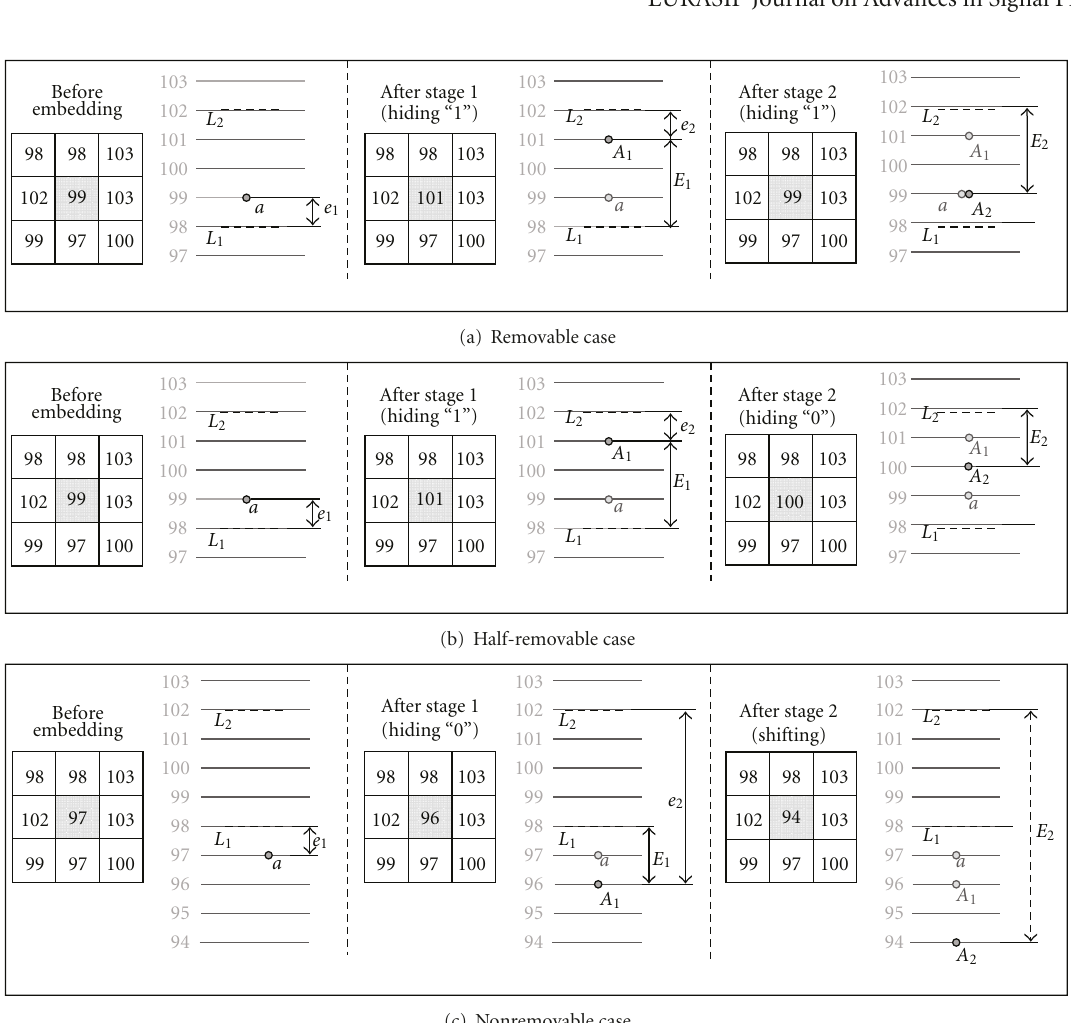
Figure 4: Di ff erent scenarios of the two-stage